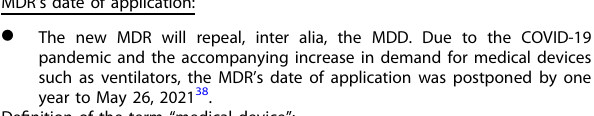
Box 1 Medical devices under the new MDR MDR ’ s date of